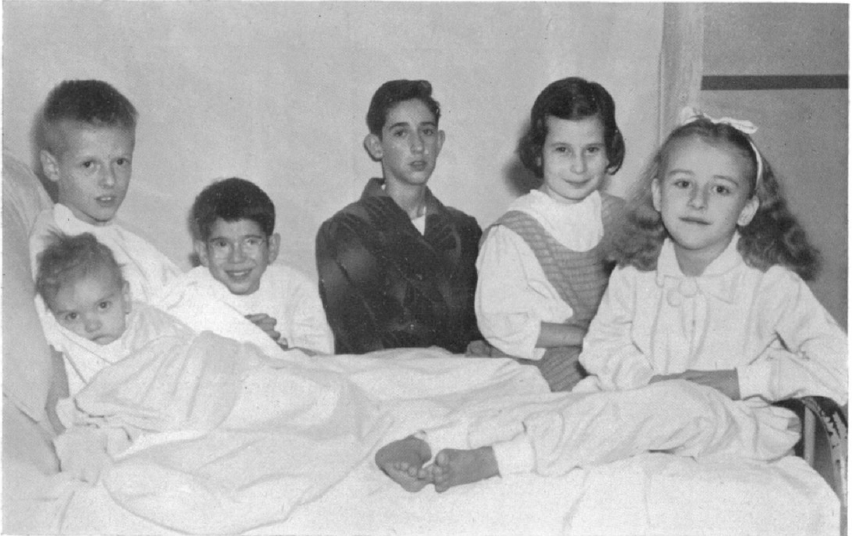
Figure 1 . These are the six surviving, of seven children operated on by the Guy’s surgeon Russell Brock during a one month exchange visit to Baltimore in 1949 during which he introduced surgery for both pulmonary and mitral stenosis to his colleagues in Johns Hopkins.